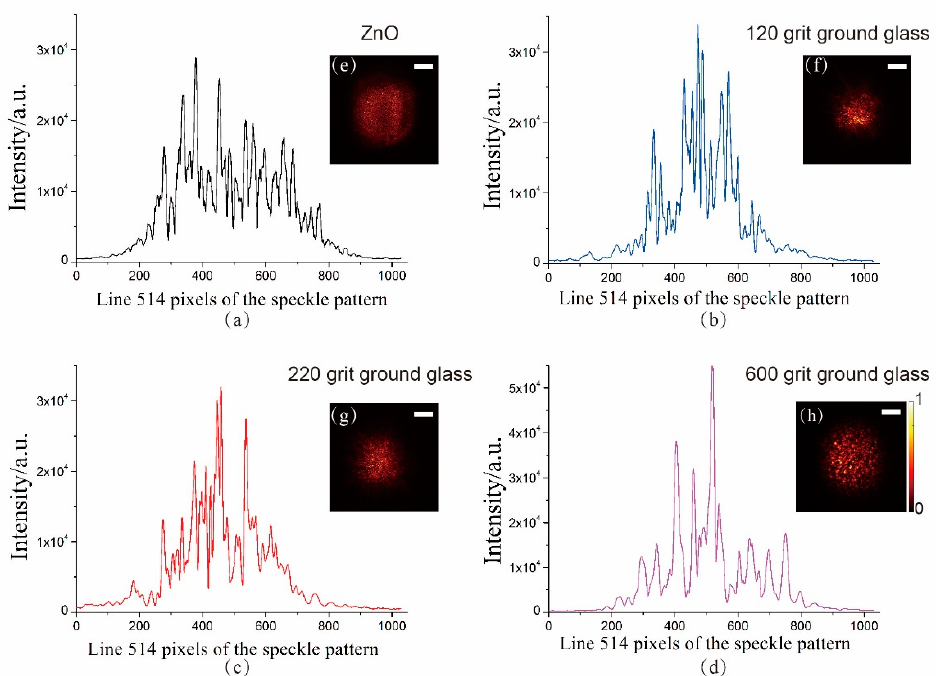
Figure 3. Speckle pattern of different scattering mediums. ( a – d ) The light intensity distribution of the 514th line of the speckle pattern with different scattering mediums. ( e – h ) The speckle pattern of different scattering mediums. Scale bar: 1.063 mm.